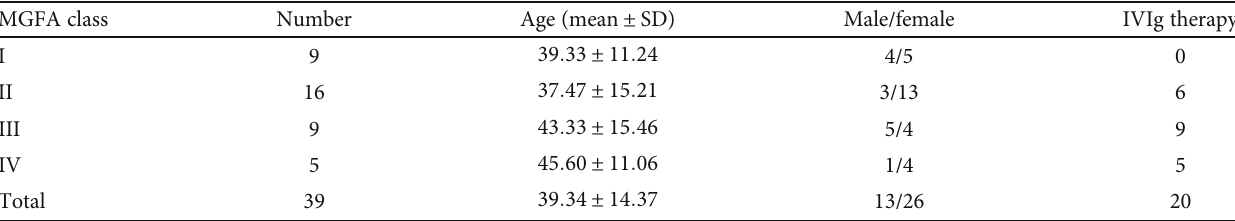
Table 1: The clinical characteristics of MG